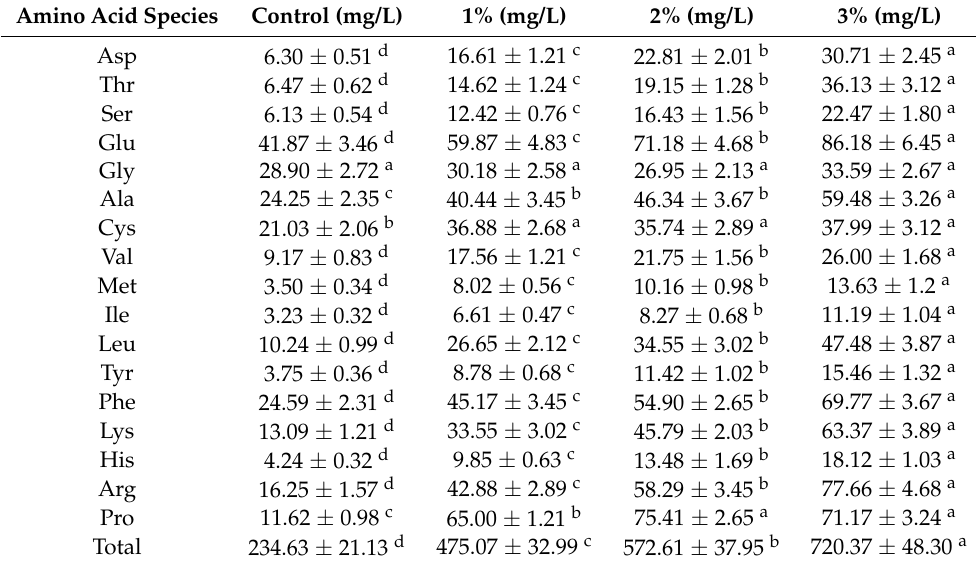
Table 4. Contents (mg/L) of free amino acids in the four mulberry fermented alcoholic beverages with different amounts of mulberry leaf powder after